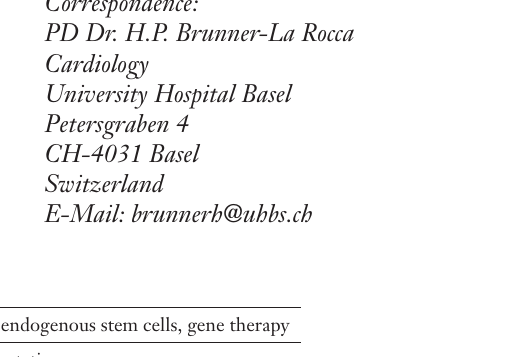
Selection of promis- ing future therapeutic approaches for end stage heart